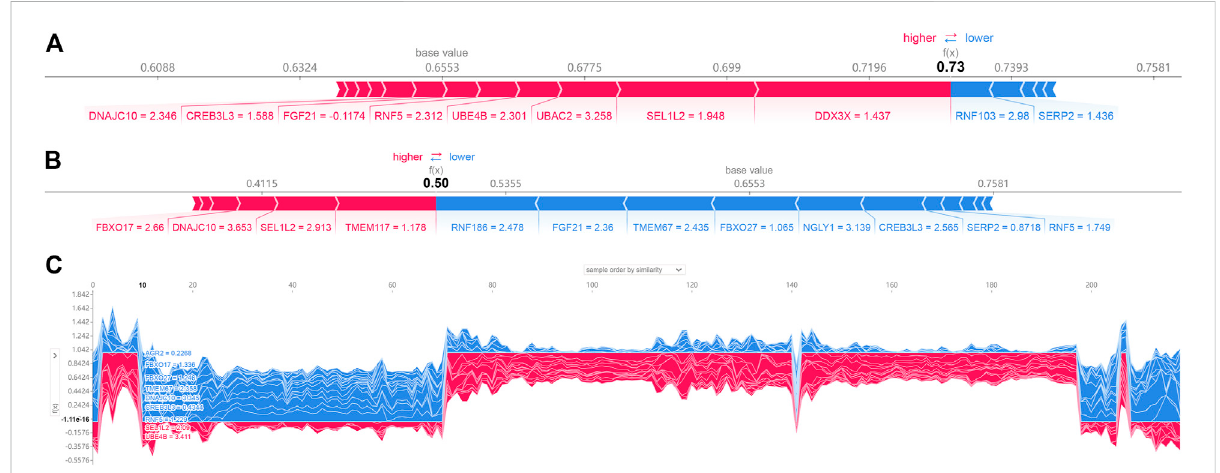
FIGURE 6 SHAPforceplotforapatient (A) andnormal (B) individual; (C) SHAPvalues(globalinterpretation)forthetestingset.Theabscissacorrespondsto each sample (normal or patient), and the ordinate corresponds to the SHAP value. More red reveals a greater overall risk for developing AD.